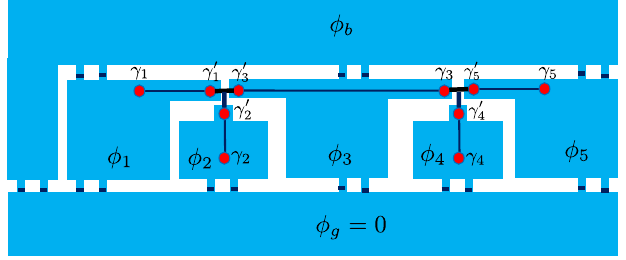
FIG. 13. A π junction designed to allow fermion parity measurements at each turning